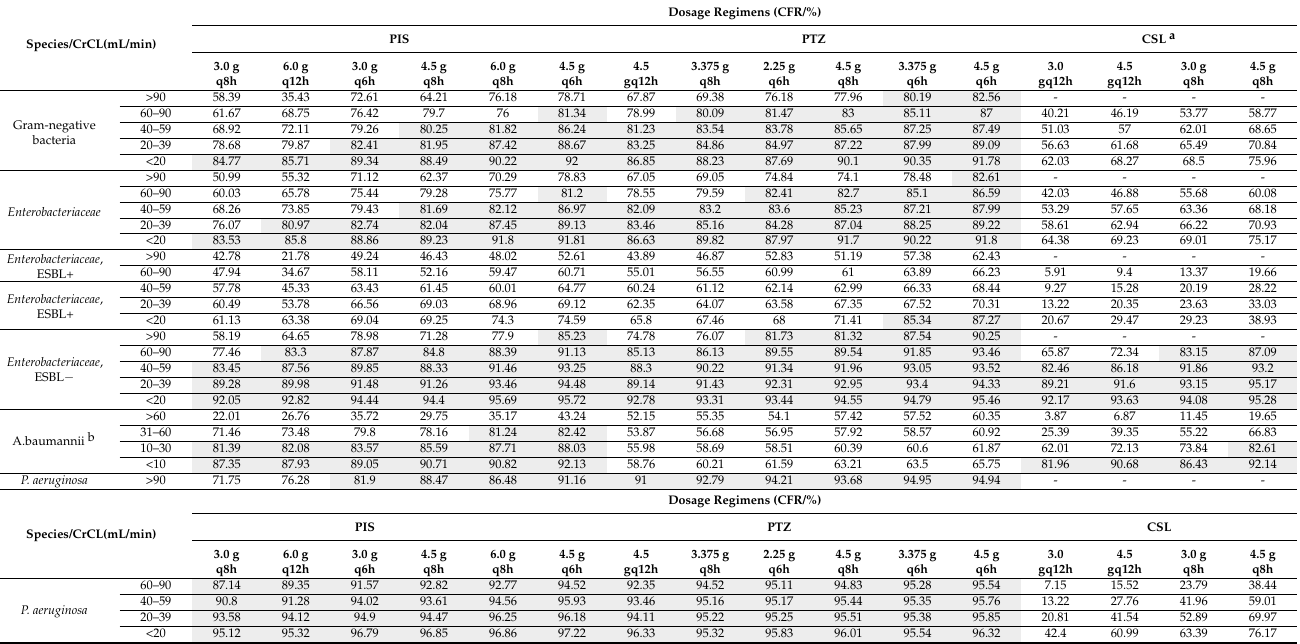
Table 2. CFRs of the different dosage regimens of PIS, PTZ, and CSL against Gram-negative isolates from blood